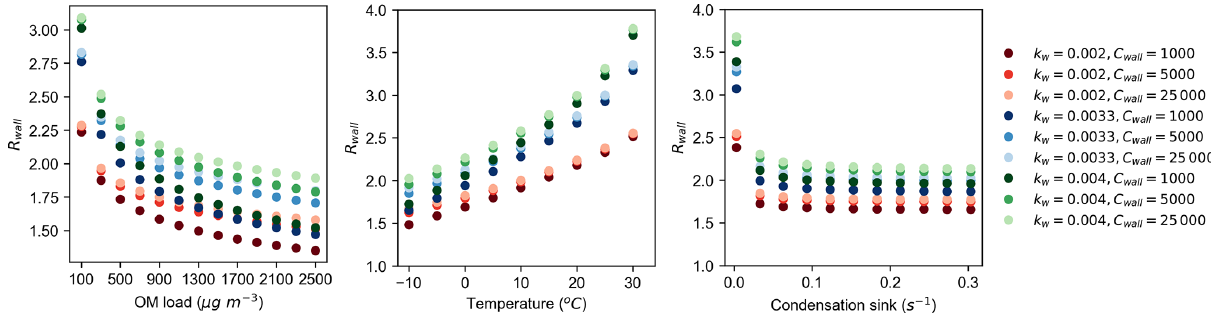
/C OA , optimal ) on initial organic mass load, temperature, and condensation k w w = 0